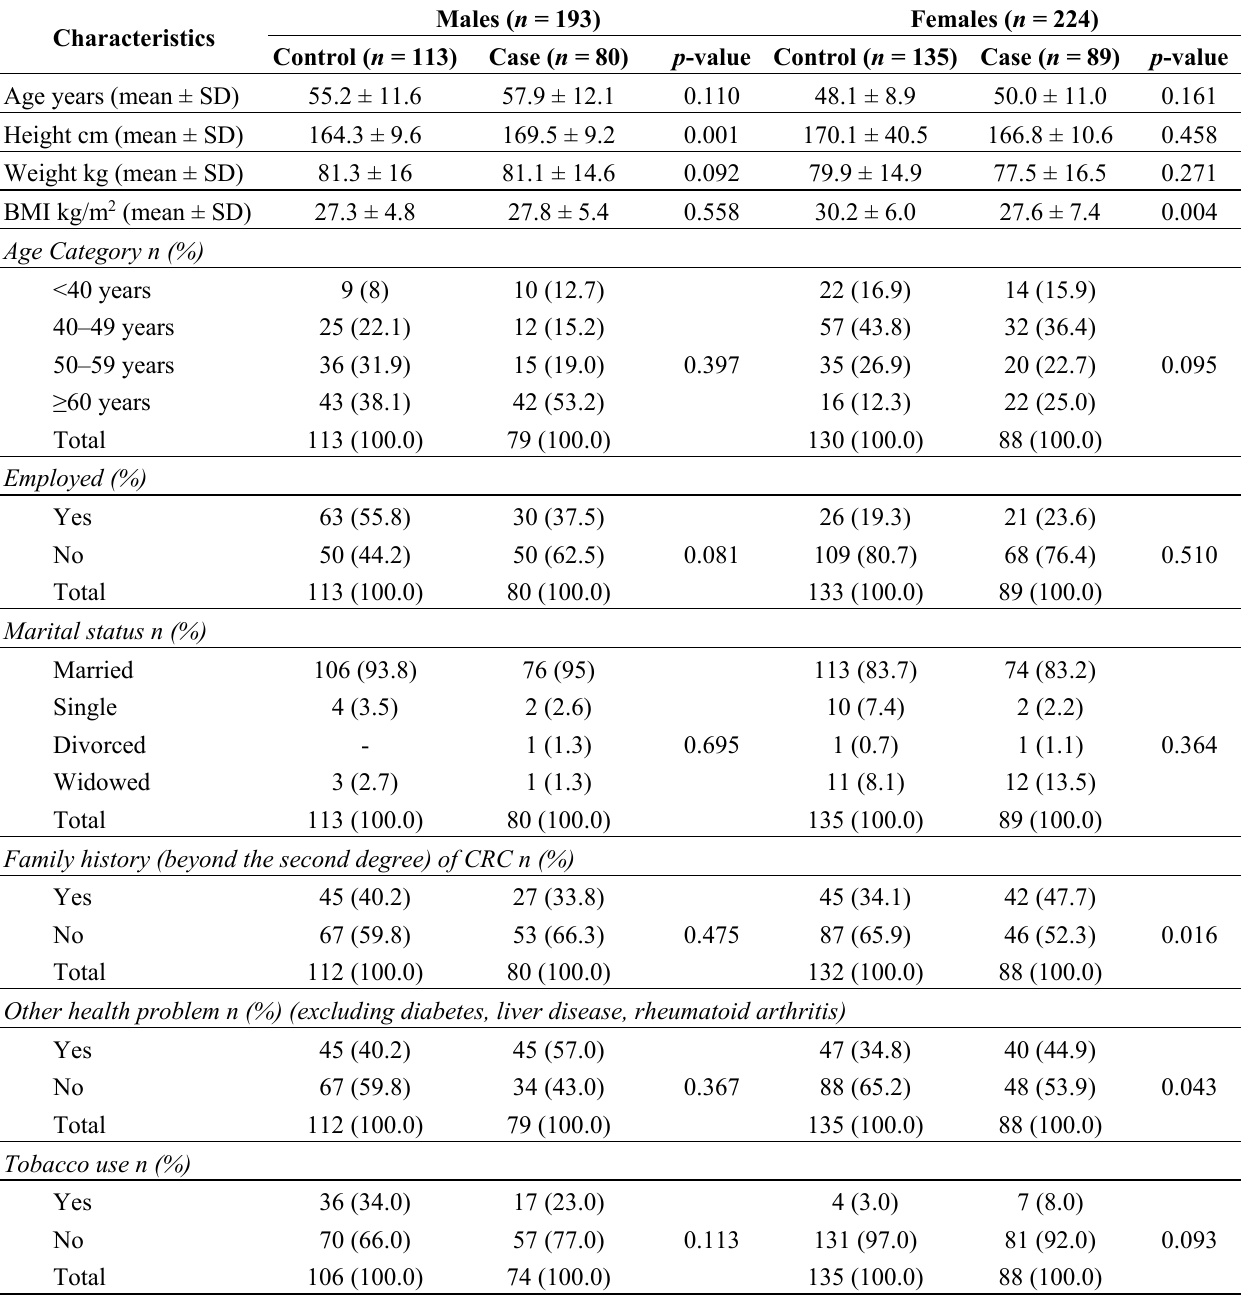
Table 1. Age, anthropometrics measurements and selected characteristics of the study participants.